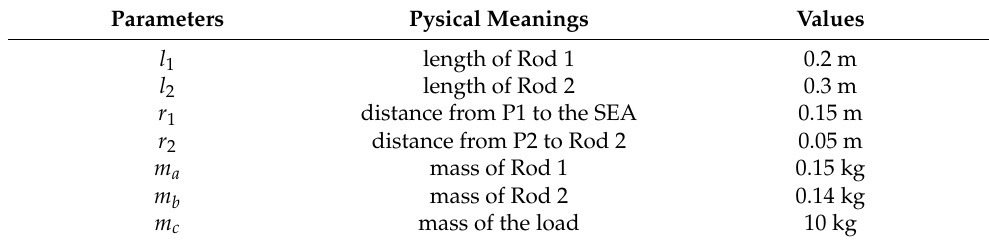
Table 1. Parameters of the Stable Platform.